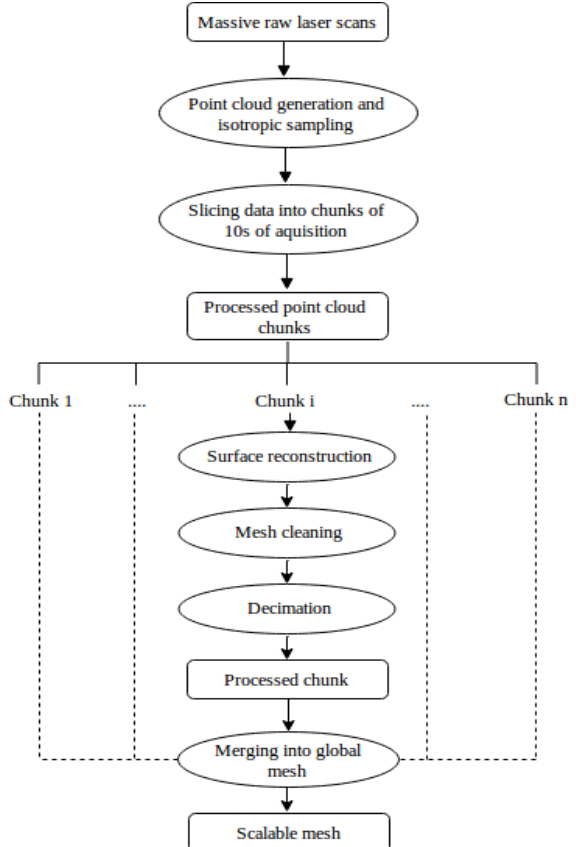
Figure 4. The proposed work-flow to produce large scale models